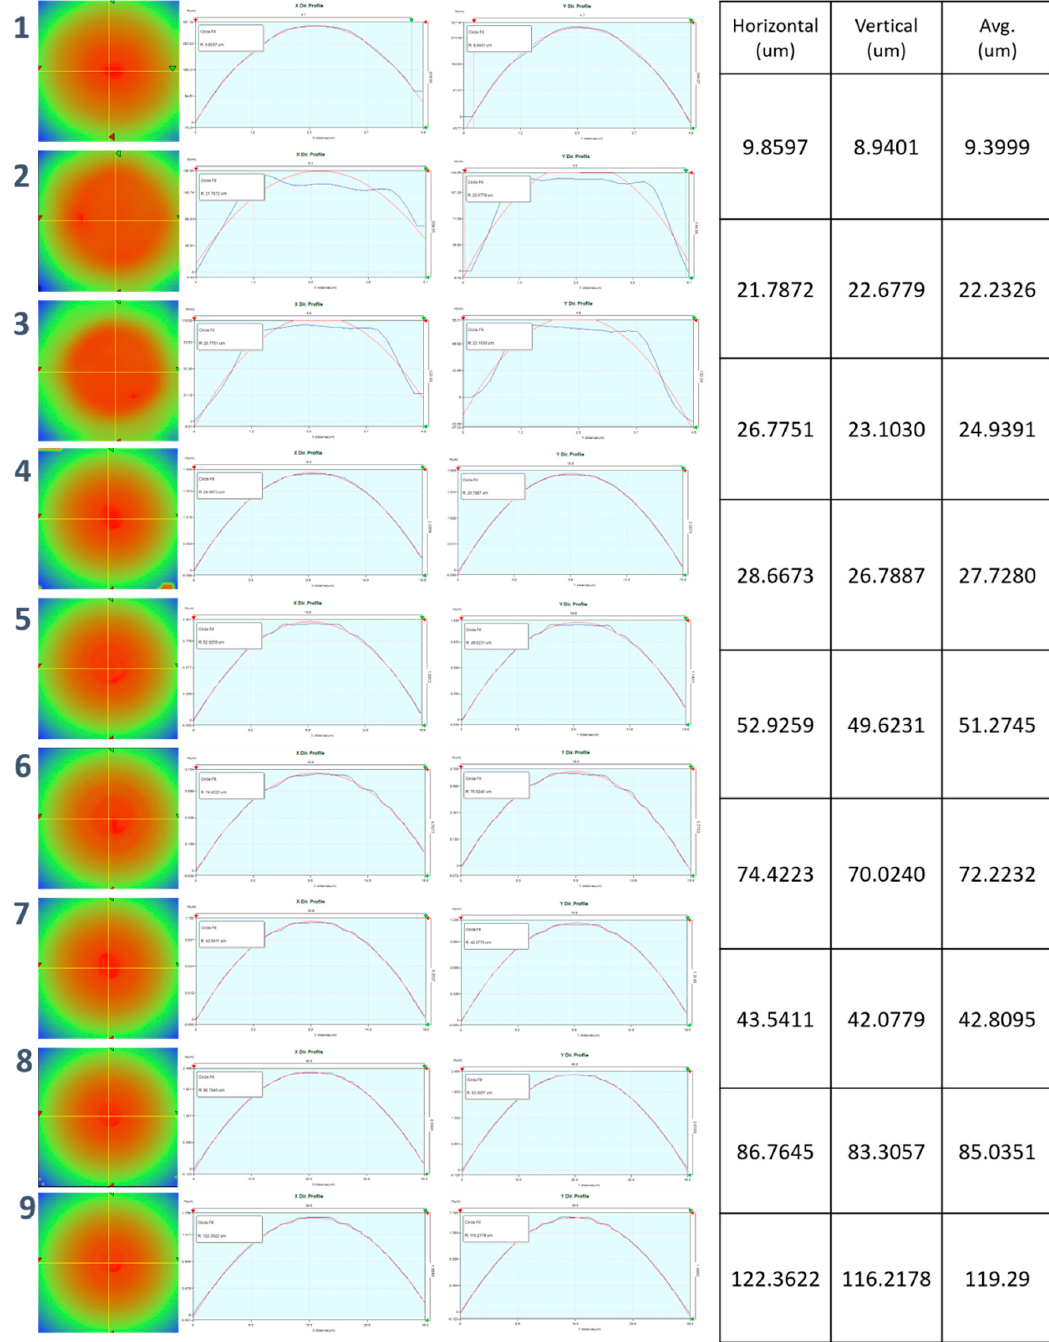
Figure A15. ROC measurement data for 4th WSM replica (PUA on PET film).